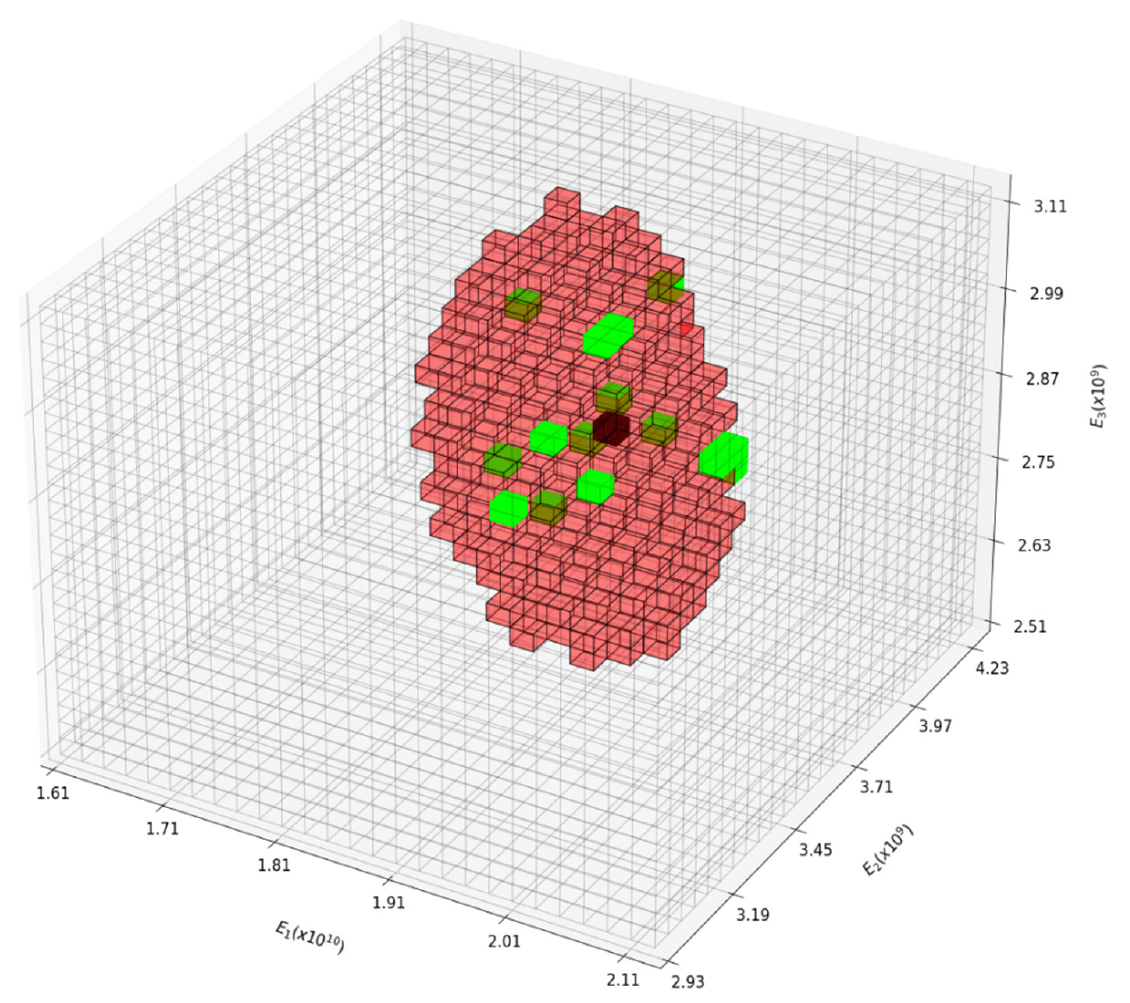
Figure 11. Sectorization 2 (3D). Number of control points: 3. E 1 , E2, and E 3 are the moduli of elasticity of concrete and foundation, riverbed, and abutments, respectively (Pa). The SD is a 3D volume obtained when applying a grid search algorithm (red in the figure). Green cubes are the 18 points that approximate the SD boundary; the lighter colored ones are on the front face of the SD and the darker ones at the back face. The black cube is the centroid.